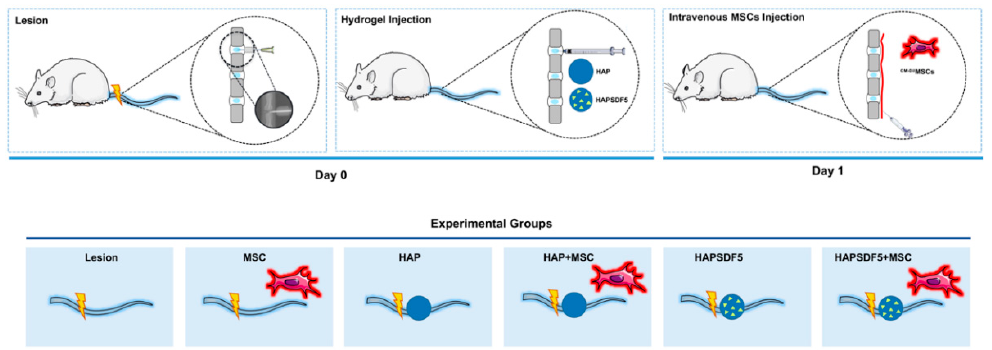
Figure 1. Experimental setup. An IVD needle injury was performed in rat caudal IVDs Co5/6, Co6/7, and Co7/8. Immediately after lesion induction, a hyaluronan-based hydrogel was administered in loco to the injured IVD with (n = 10) or without (n = 10) rat SDF-1. Lesioned only animals were kept as a control group (n = 10). For each of these groups, part of the animals (n = 5 each) had bone marrow MSC administered 24 h post-injury.